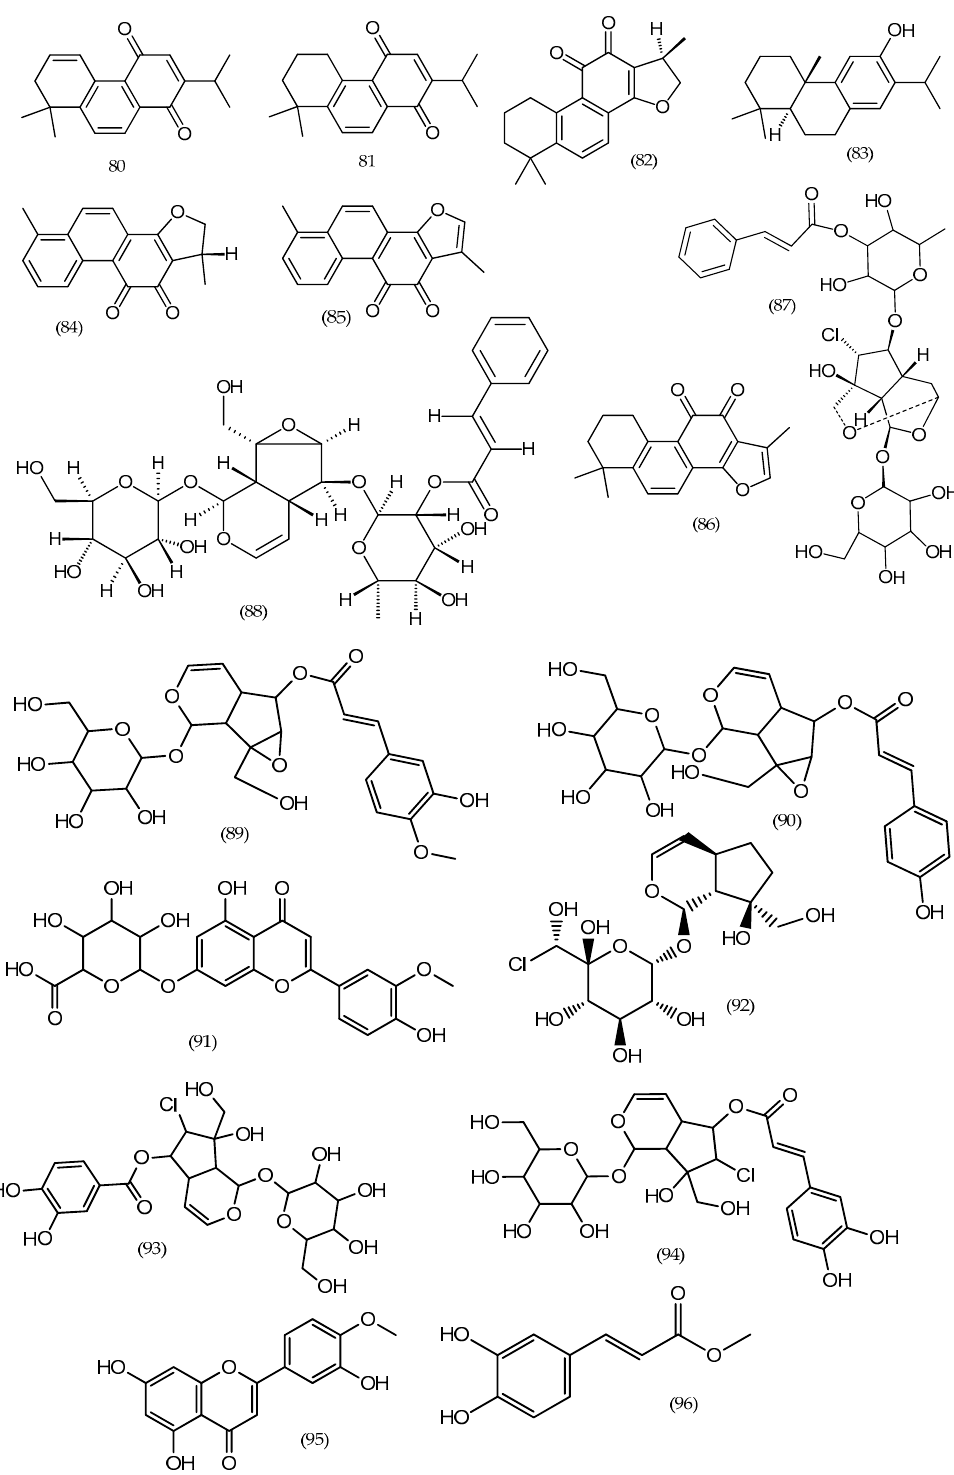
Figure 14. Several phytoconstituents in Veronica sibirica and Veronica peregrina. 2.16. Veronica Montana L., Veronica Polita Fr., and Veronica Spuria L.